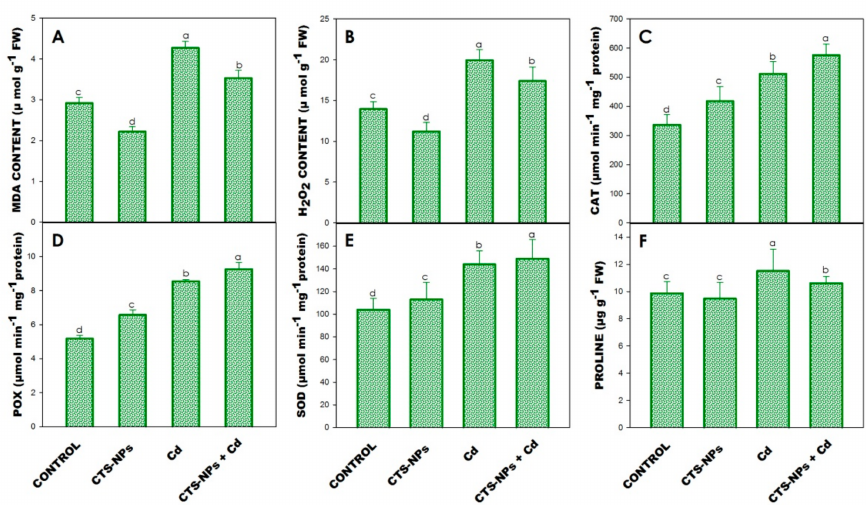
Figure 3. Effect of foliar application of chitosan nanoparticles (CTS-NPs) on the contents of MDA ( A ), H 2 O 2 ( B ), CAT ( C ), POX ( D ), SOD ( E ) and proline ( F ) in cadmium (Cd) stress Solanum lycopersicum at 30 days after sowing. Values are the mean of five replicates with standard errors. Different bar letters show significant differences among treatments separately.